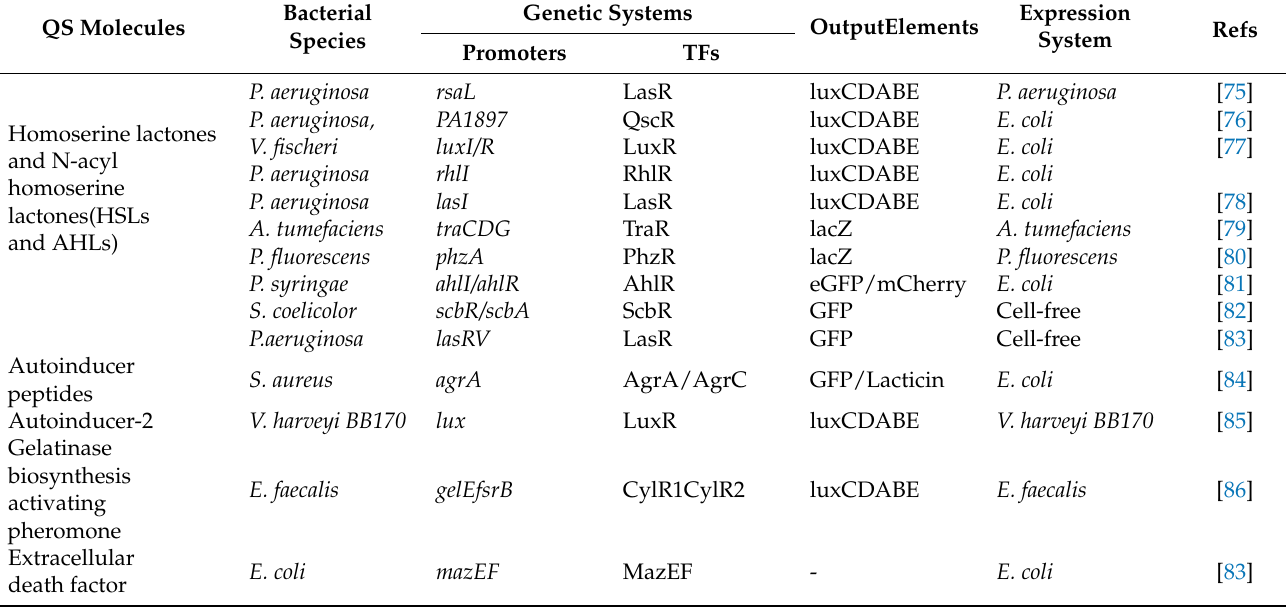
Table 2. TF-based biosensors detecting quorum sensing